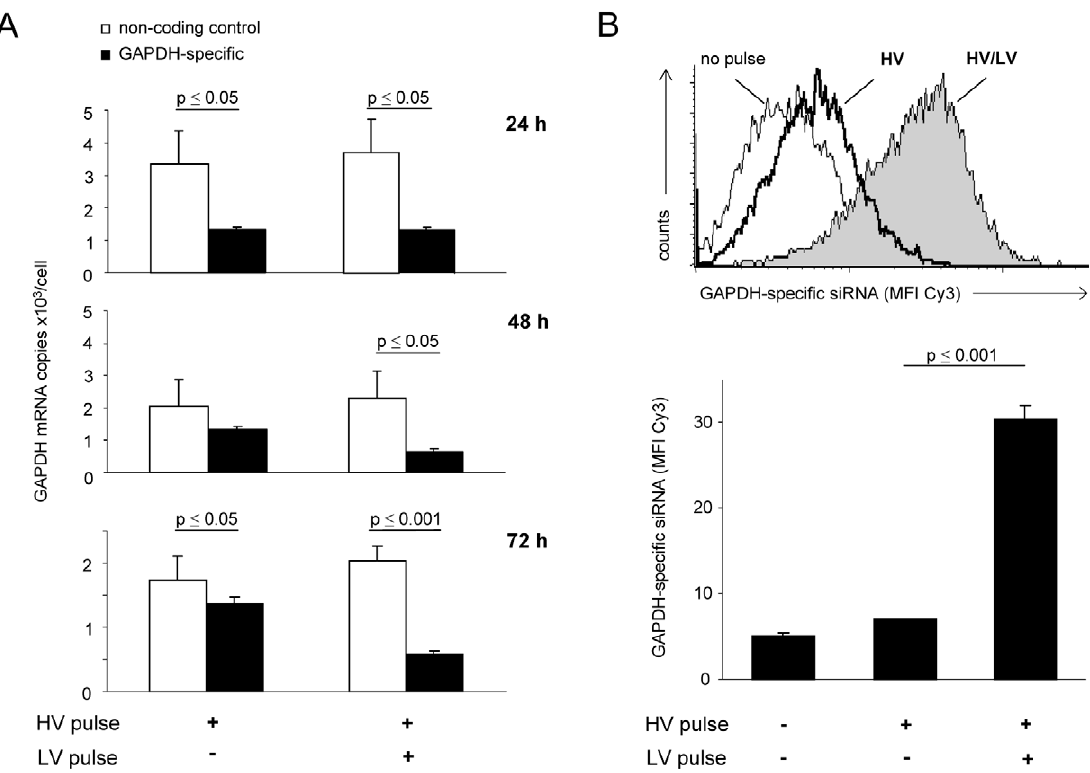
Figure 5. Long-term outcome of transfection of primary preadipocytes with GAPDH-specific siRNA. Primary preadipocytes were transfected with 120 pmol Cy3-labeled GAPDH-specific siRNA or a non-coding siRNA for control using a single HV pulse (3 kV/cm, 400 m s) or a combined HV/LV pulse (3 kV/cm, 400 m s and 1.5 kV/cm, 5 ms) produced by the ELPorator 1000 device. (A) After 24, 48 and 72 h, copy numbers of GAPDH-specific mRNA were determined by quantitative PCR in comparison to a cloned plasmid standard. Mean values 6 SEM; n=6. (B) As directly assessed by flow cytometry 5 h after transfection, uptake of Cy3-labeled GAPDH-specific siRNA by preadipocytes was determined via the MFI. Representative histogram and mean values 6 SEM; n=4.